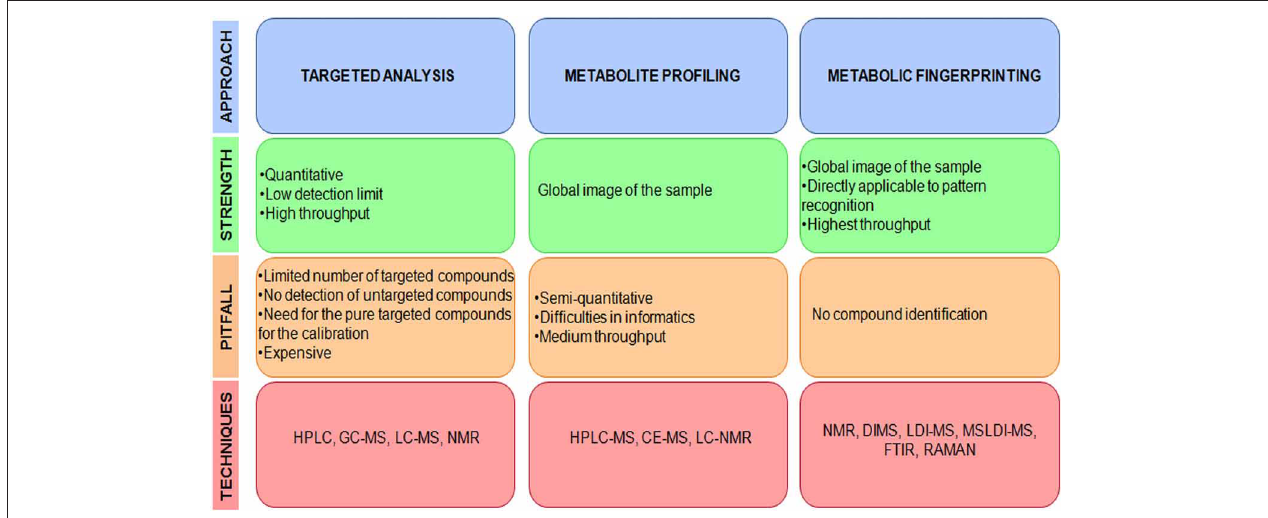
FIGURE 2 | Different approaches and respective techniques: pitfalls and strengths. The employed technique depends on the followed approach: targeted analysis, metabolite profiling, and metabolic fingerprinting.